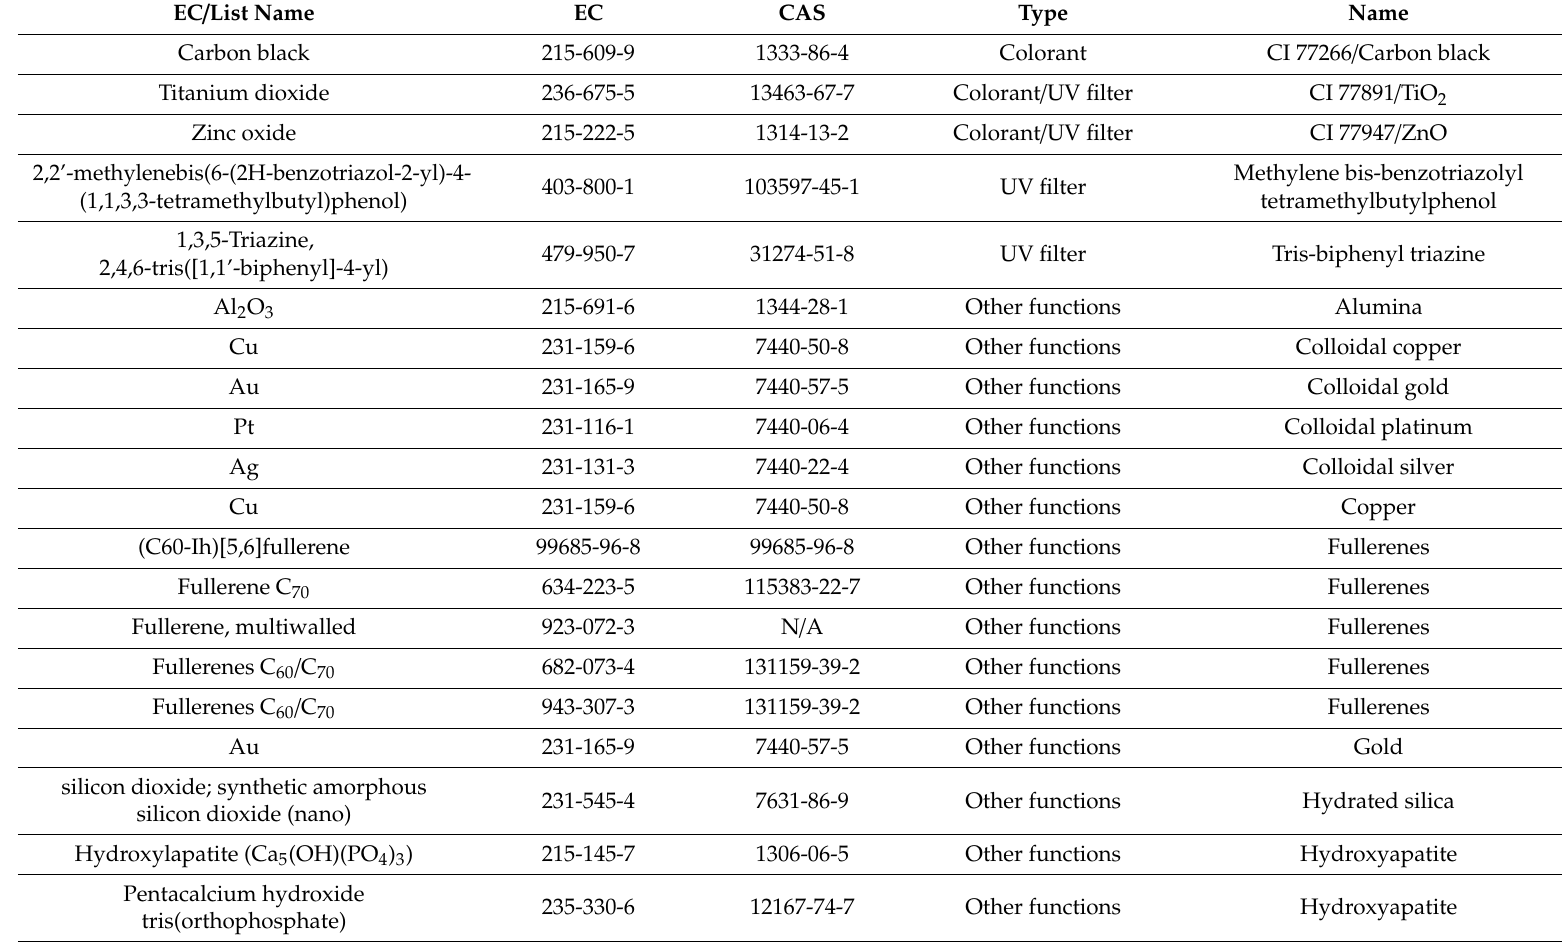
Table 1. Catalogue of cosmetic ingredients registered in